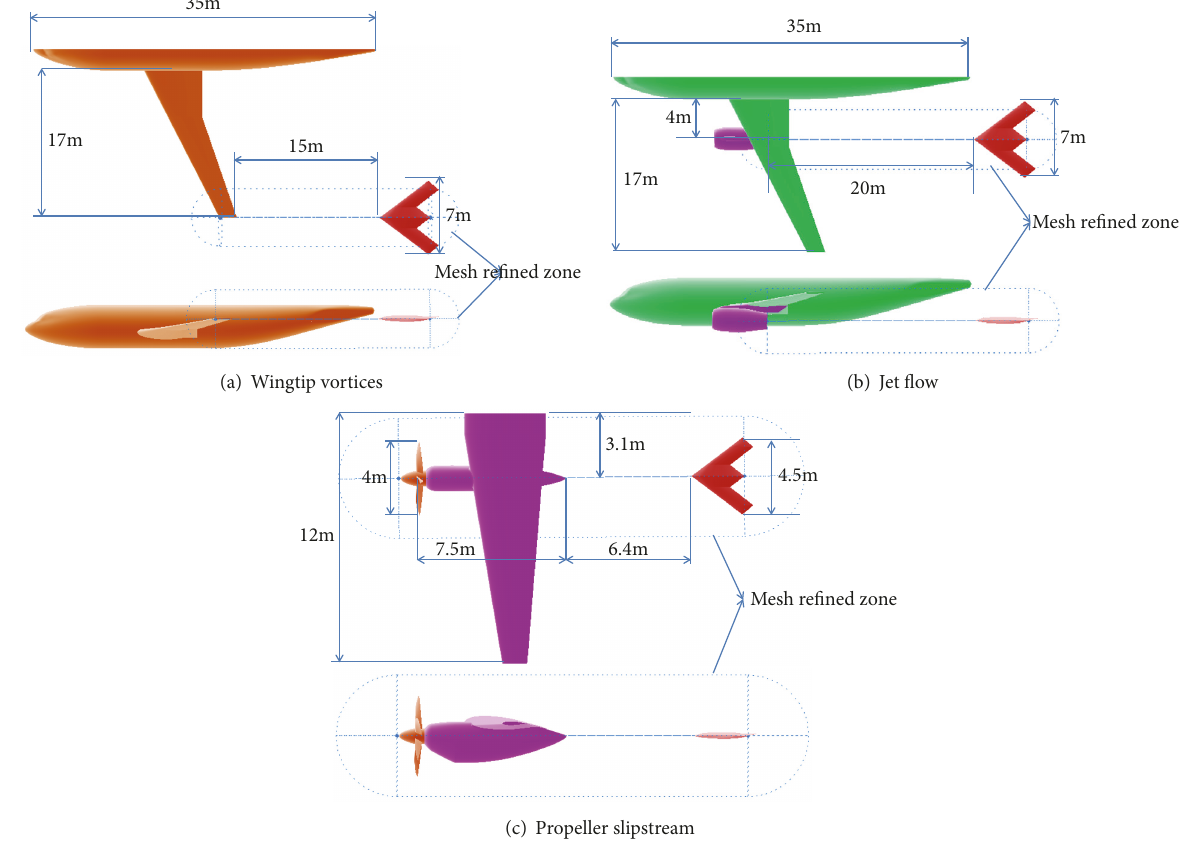
Figure 5: Computational